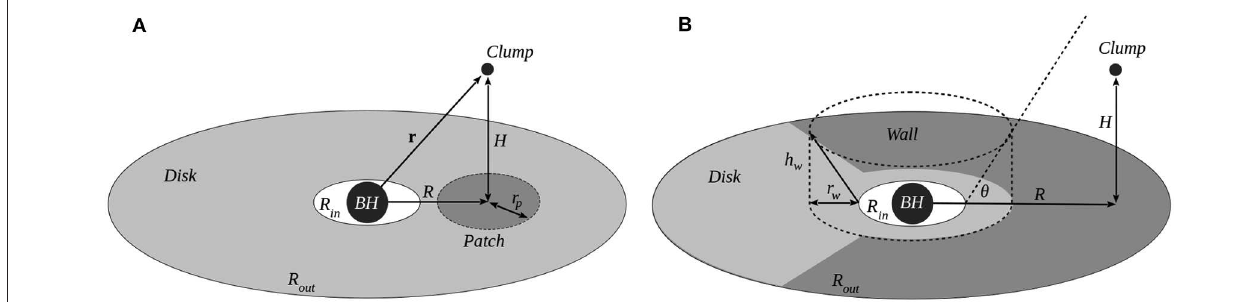
FIGURE 1 | Illustration of shielding models. The disk is shown in light gray in both models, while the visible area of the disk (not shielded) to the clump is recolored to dark gray. In Patch Model (A) , the radius ( r p ) of the patch which is not drawn in scale is linearly proportional to the height ( H ) of the clump from the AD surface. In Wall Model (B) , the radius ( r w ) of the cylindrical shell is linearly proportional to the height ( h w ) of the wall while β = tan( θ ) is constant. The visible area of the disk to the clump varies due to the changes in the size of patch and wall while the clump is moving. In order to keep the figures neat and clean, the conceptual location of BLR in , and also the torus [BLR out to R out ] are not